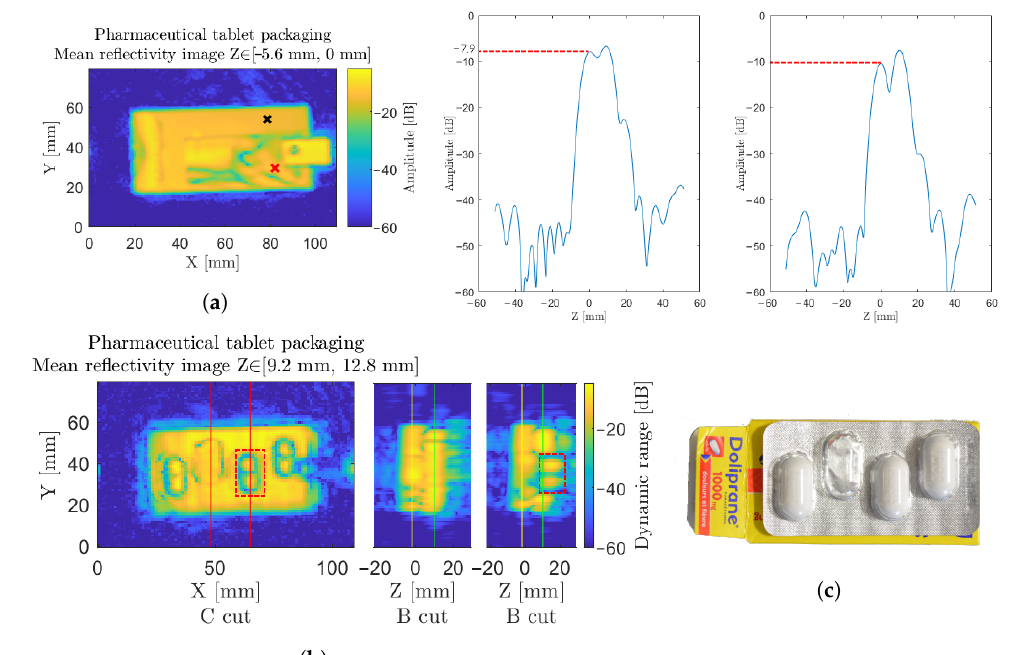
Figure 17. ( a ) Pharmaceutical sample under inspection, considered on a longitudinal range of interest, for the front packaging and instruction leaflet. The red cross corresponds to the leaflet and is drawn on the plot in the middle, and the black cross corresponds to the nonexistent leaflet drawn on the right. ( b ) The tablets in their blister pack, completed by two B cuts along the vertical lines, with red markers at x = 50 mm and x = 65 mm. Yellow and green markers indicate the cardboard interface and the blister pack metallic interface, respectively, on the B cuts. One pill is highlighted through the orange dotted box on both cuts. ( c ) Photography of the pharmaceutical